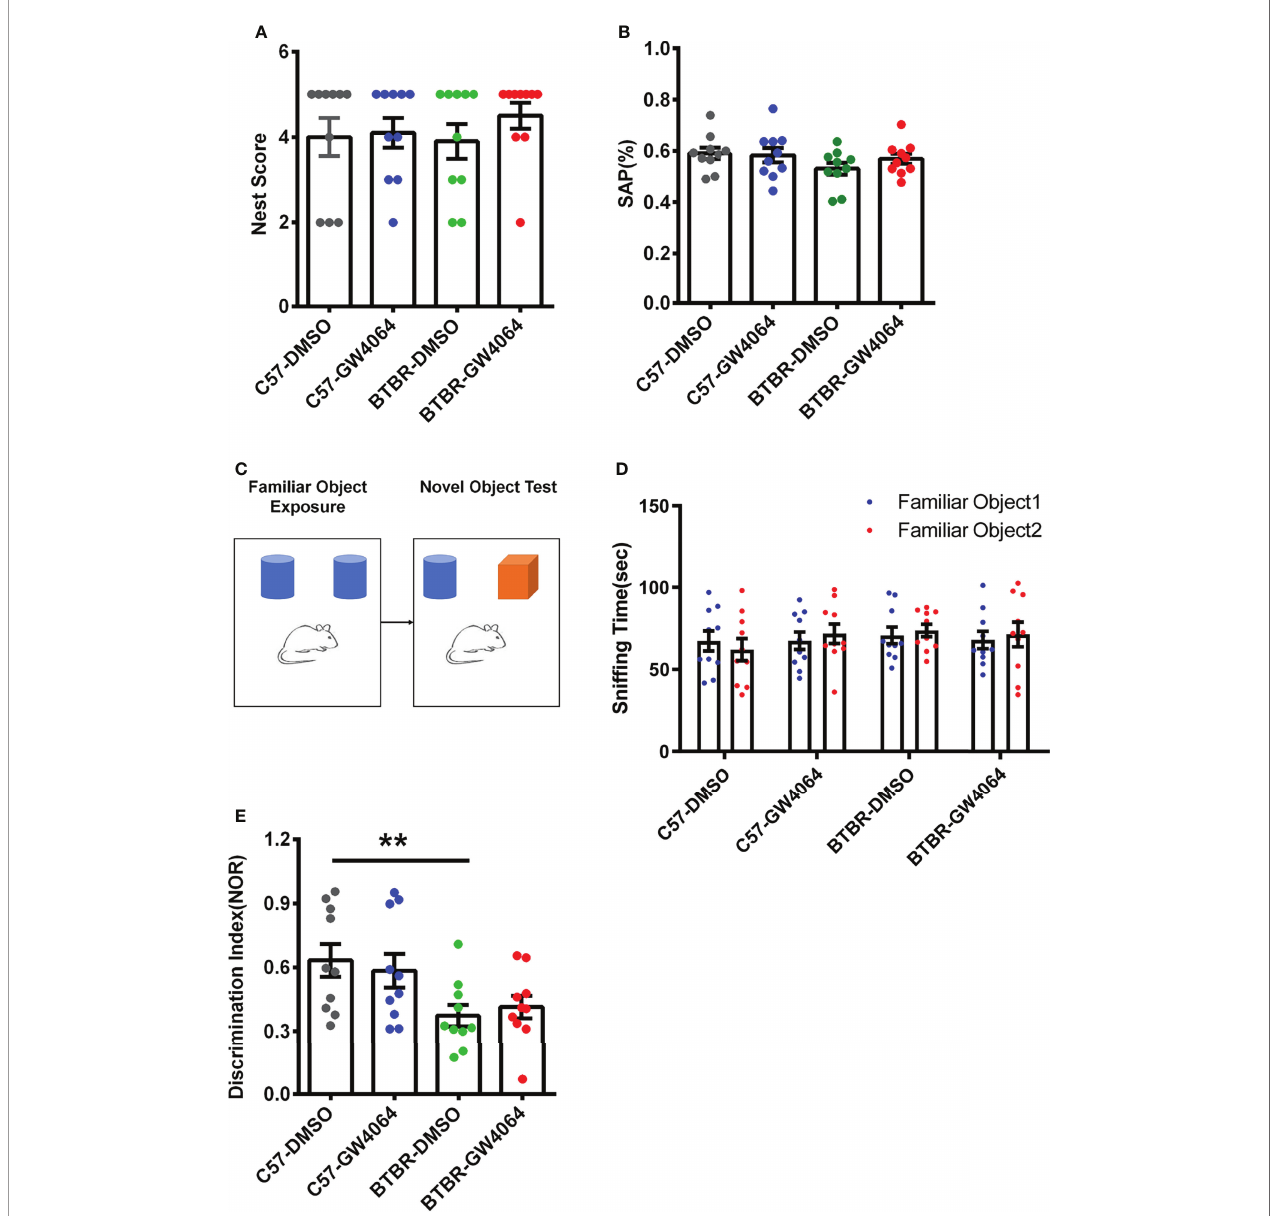
FIGURE 3 | GW4064 treatment did not alter performance in the nest building and Y-maze tests and did not rescue short-term memory de fi cits in BTBR mice. (A, B) GW4064 treatment did not alter the nest scores in the nest building and the percentage of SAP in the Y-maze test. (C) Schematic illustration of the new object recognition task. After a period of exposure, one of the two familiar objects is replaced by another unfamiliar one, then test the time the mice stay with the novel object and the familiar object. (D) The snif fi ng time of new object recognition has no obvious preference between the familiar object 1 and the familiar object 2 during the initial learning phase. (E) BTBR mice displayed a lower discrimination index than C57 mice, which were not rescued by GW4064 treatment. The data are presented as the mean ± SEM. n = 10. **p <